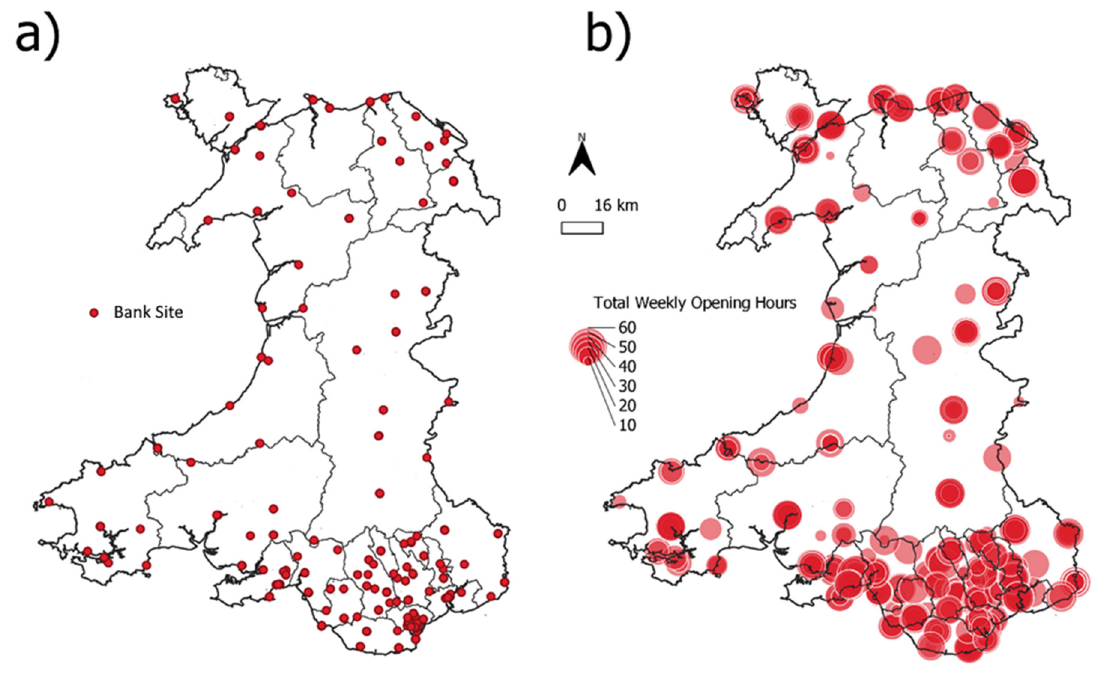
Figure 1. ( a ) Branch locations and ( b ) total weekly opening hours.